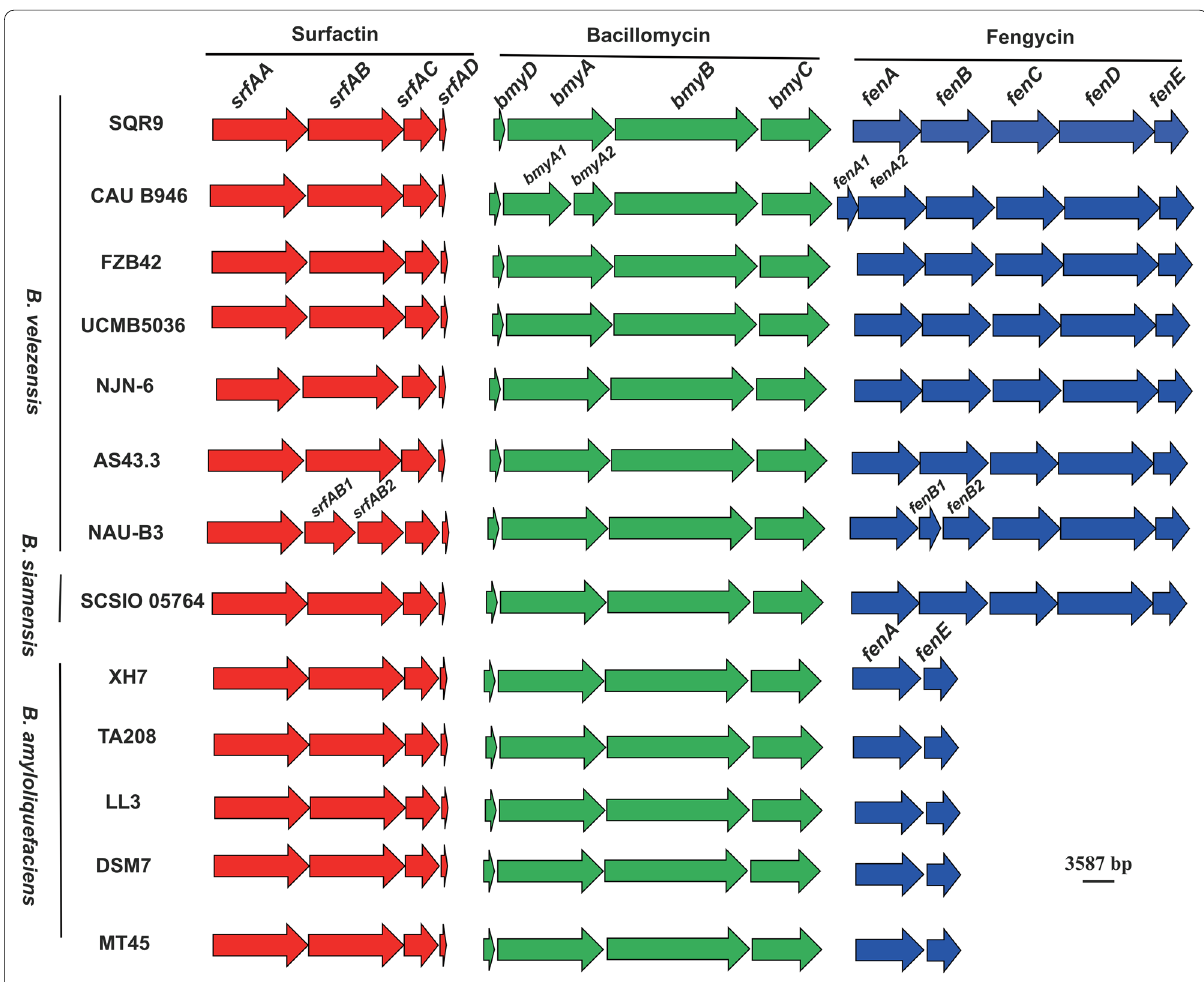
Fig. 4 Illustration of lipopeptide biosynthesis gene clusters in the B. amyloliquefaciens group